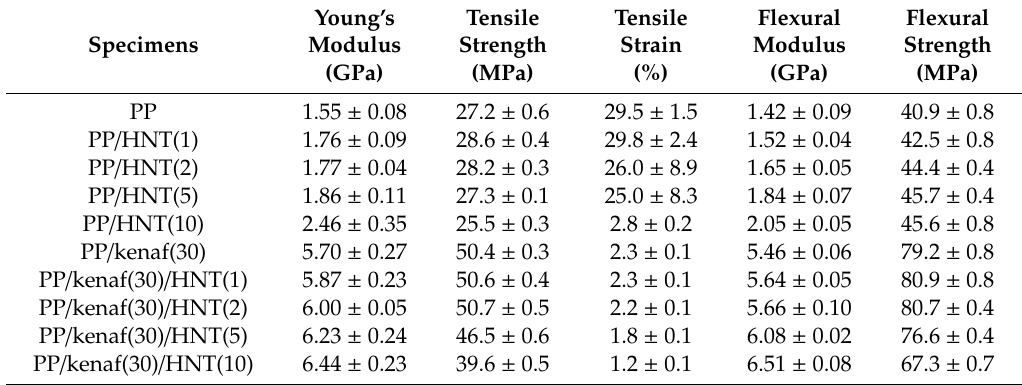
Figure 5. Flexural stress – strain curves for PP, PP/HNT, PP/kenaf, and PP/kenaf/HNT reinforced with different volumetric content of 1, 2, 5 and 10 vol. % of HNT. Table 2. Mechanical properties of PP, PP/HNTs NCs, PP/kenaf, and PP/kenaf/HNTs hybrid biocomposites.